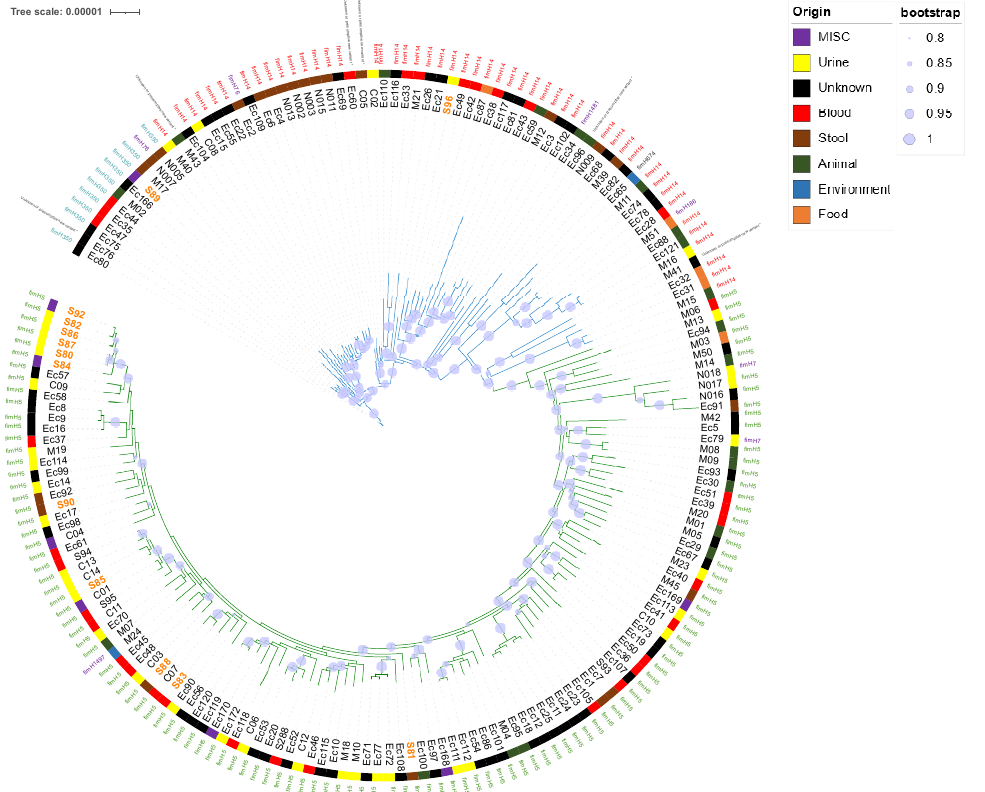
Figure 1. Representation of the two main E. coli ST141 sublineages obtained from maximum likelihood phylogeny SNP-based free-recombinant tree inferred from alignment to a fully sequenced reference strain of E. coli